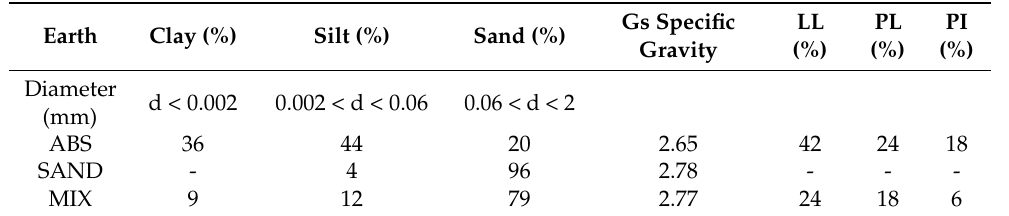
Table 1. Grain size distribution, specific gravity and Atterberg limits of soil (ABS), SAND, and MIX (1:3 soil-to-sand ratio). Liquid limit (LL), plastic limit (PL) and plasticity index (PI) are also reported [20]. Copyright 2021 Scientific.Net.